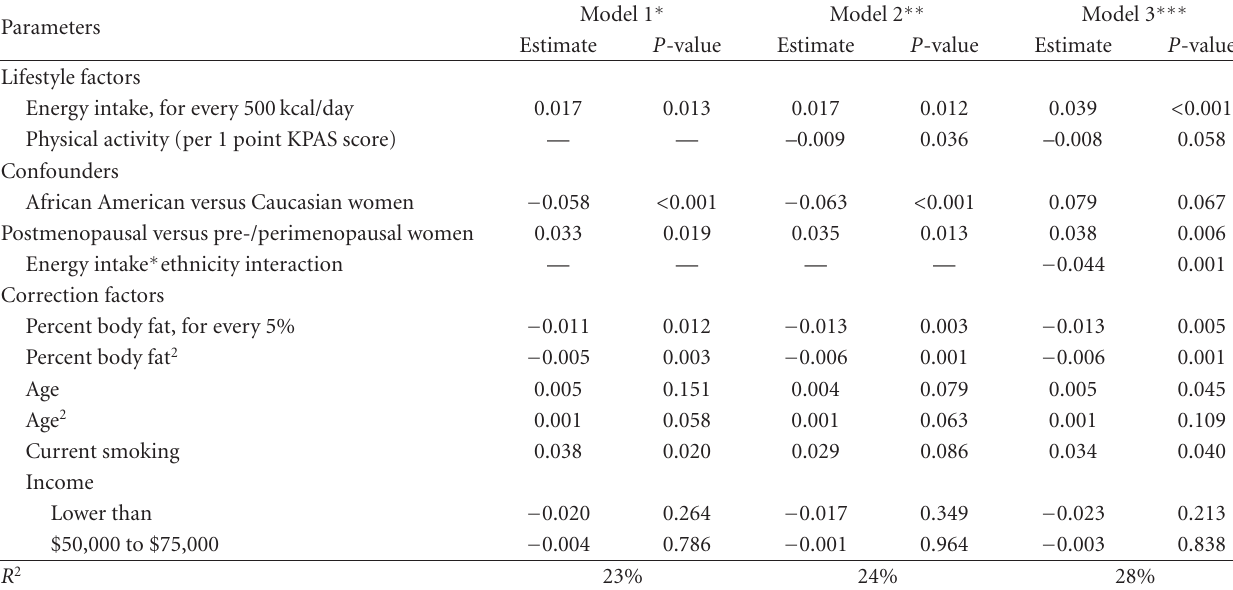
Table 3: Multivariable models of association between self-reported energy intake with ratio of intra-abdominal adipose tissue to sub- cutaneous abdominal adipose tissue (IAT:SAT